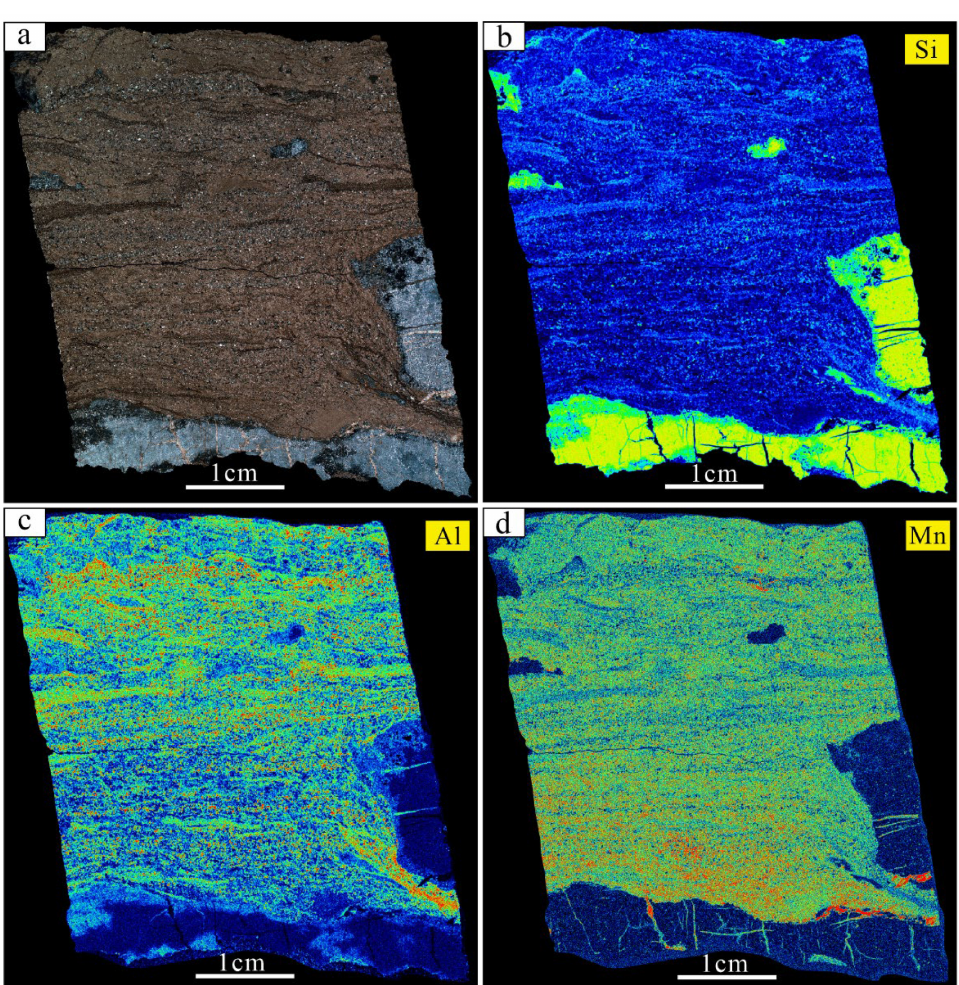
Figure 5. Optical photomicrograph and Micro-XRF mapping images show elemental distribution of one representative large thin section from the Lucaogou Formation from the Junggar Basin, NW China. Elemental maps (false-color images) of Si-K α , Al-K α and Mn-K α . ( a ) Chert nodules in surrounding rocks are unevenly distributed, XPL; ( b ) elemental map of Si; ( c ) elemental map of Al; ( d ) elemental map of